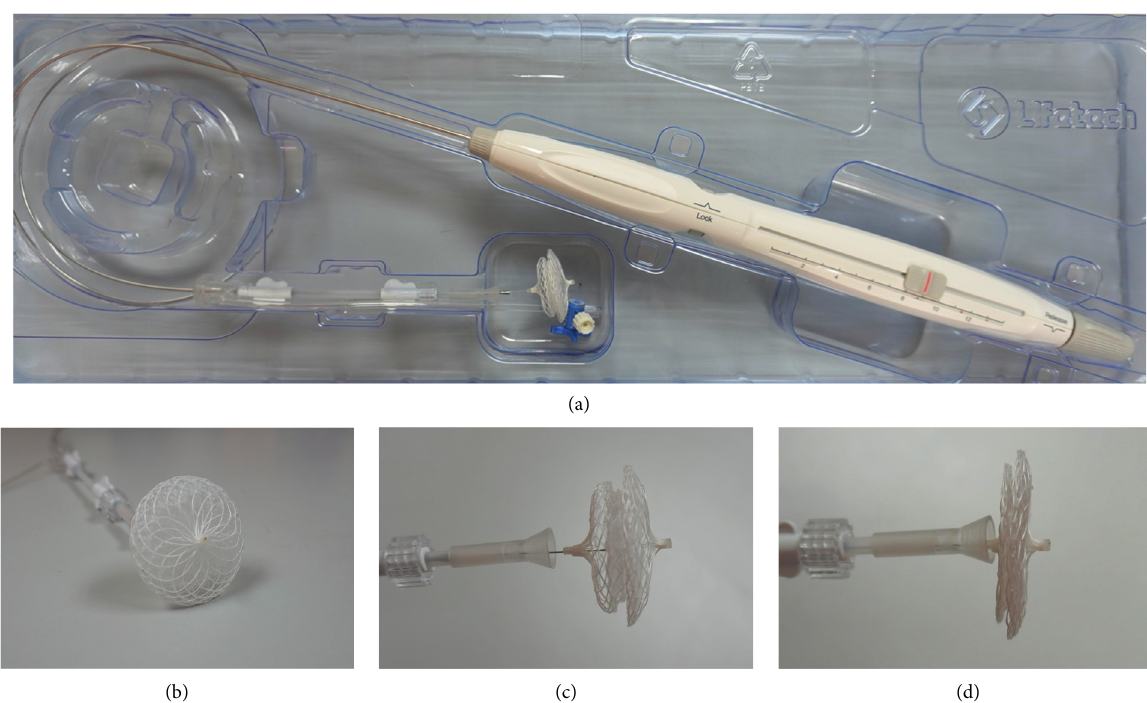
Figure 1: The Absnow ™ ASD closure system and the structure of the PLLA device. (a) The integral structure of the Absnow ™ ASD closure system. (b) Frontal view of the PLLA device. (c) The unlocked state of the PLLA device. (d) The locked state of the PLLA device.